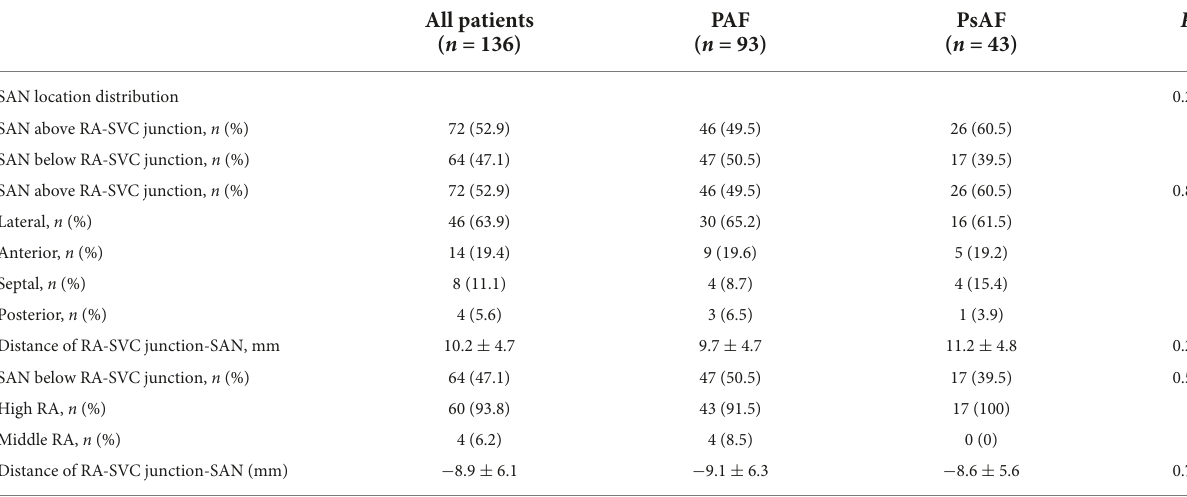
TABLE 5 Distribution of EAA of SAN in patients with AF.